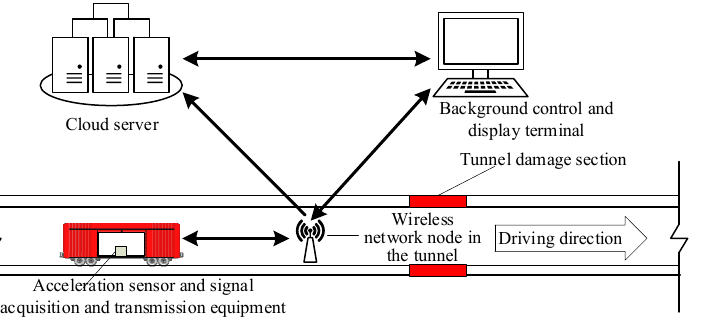
Figure 1. Remote wireless tunnel monitoring scheme based on dynamic response of train in service.